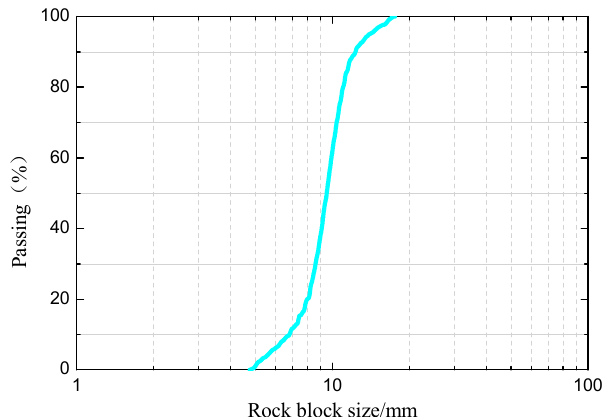
Figure 2. Block gradation curve.